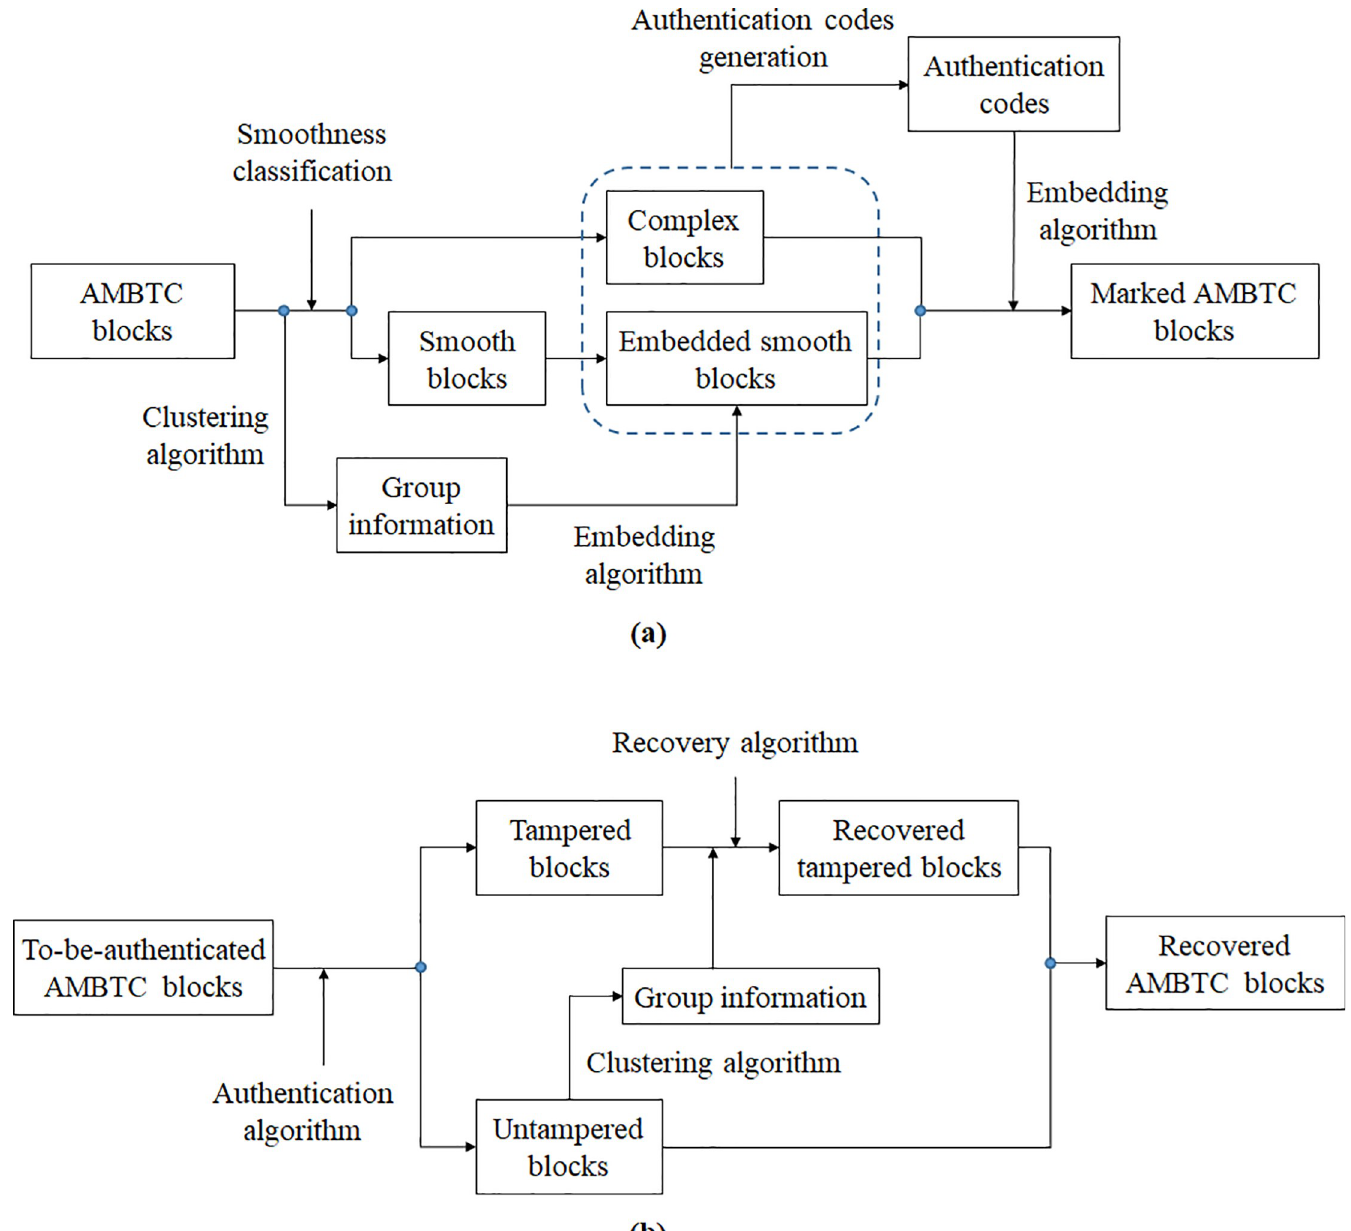
Fig 1. The framework of the proposed method. (a) The embedding procedures. (b) The authentication and recovery procedures.